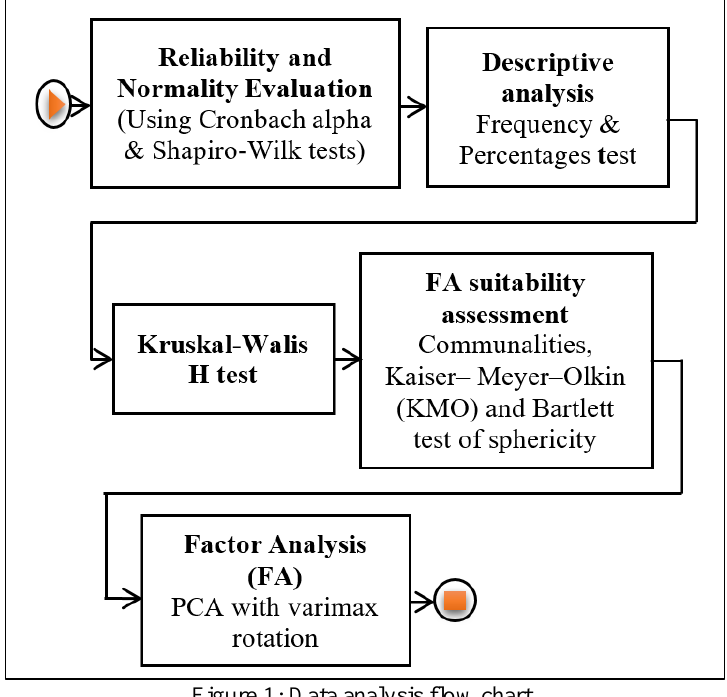
Figure 1: Data analysis flow